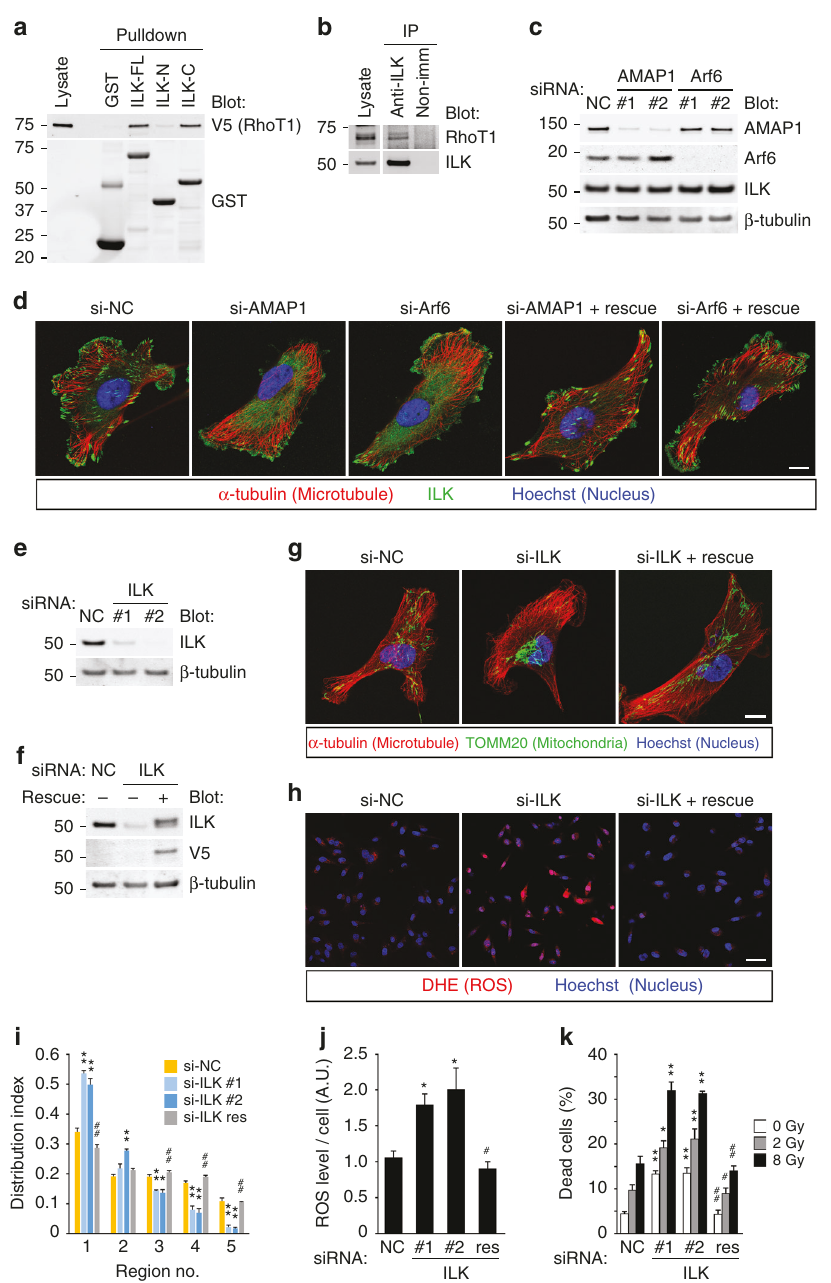
Fig. 4 Localization of ILK at FAs is essential for regulation of mitochondrial distribution. a GST-pulldown assay using lysates from 293T cells overexpressing V5-tagged RhoT1 and the full length (ILK-FL), N terminus (ILK-N) or C terminus (ILK-C) of ILK fused to GST. GST alone (GST) was also used as a control. b Immunoprecipitation using MDA-MB-231 cell lysates and the anti-ILK antibody. Nonimmune rabbit IgG (non-imm) was also used as a control. c , d MDA-MB-231 cells were transfected with siRNAs targeting AMAP1 or Arf6. Protein expression of AMAP1, Arf6, or ILK was analyzed by western blot ( c ). ILK (green), microtubules (red), and nuclei (blue) were fl uorescently visualized by speci fi c antibodies or dyes. Bar, 10 μ m ( d ). e – k MDA-MB-231 cells, either parental or stably transfected with ILK cDNA refractory to siRNA, were transfected with siRNAs targeting ILK. Protein expression of ILK was analyzed by western blot ( e , f ). Mitochondria (green), microtubules (red), and nuclei (blue) were fl uorescently visualized by speci fi c antibodies or dyes. Bar, 10 μ m ( g ). Mitochondrial distribution indices were quanti fi ed ( i ). ROS production was visualized by DHE ( h ), and quanti fi ed ( j ). Bar, 50 μ m. Cells were exposed to the indicated doses of IR, and cumulative cell death was measured ( k ). All graphs indicate the mean ± SEM for three independent experiments. * and ** indicate P < 0.05 and P < 0.005 (two-tailed t -test, adjusted by the Holm – Sidak method), compared to the corresponding samples (si-NC vs. si-ILK #1 or #2),